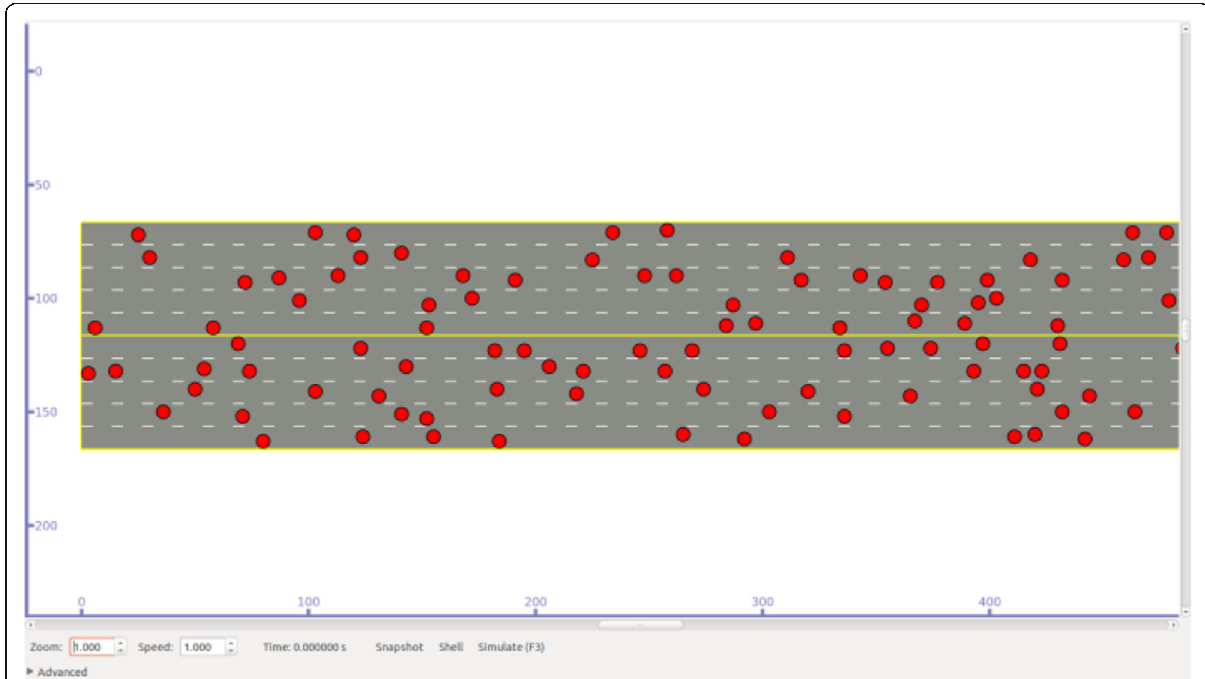
Fig. 7 A snippet of multi-lane highway mobility model in NS3